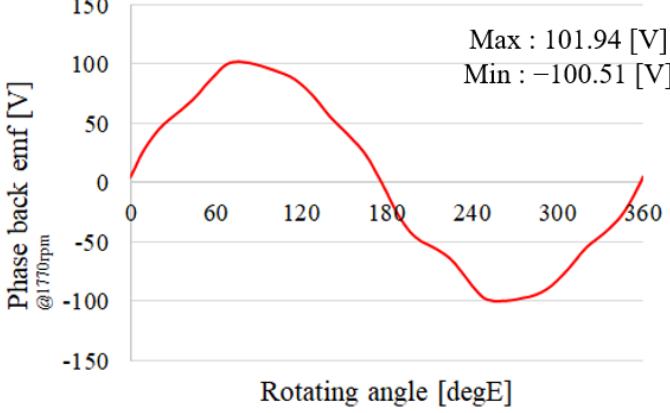
Figure 9. Waveform of phase back emf (skew angle 2.5 deg).